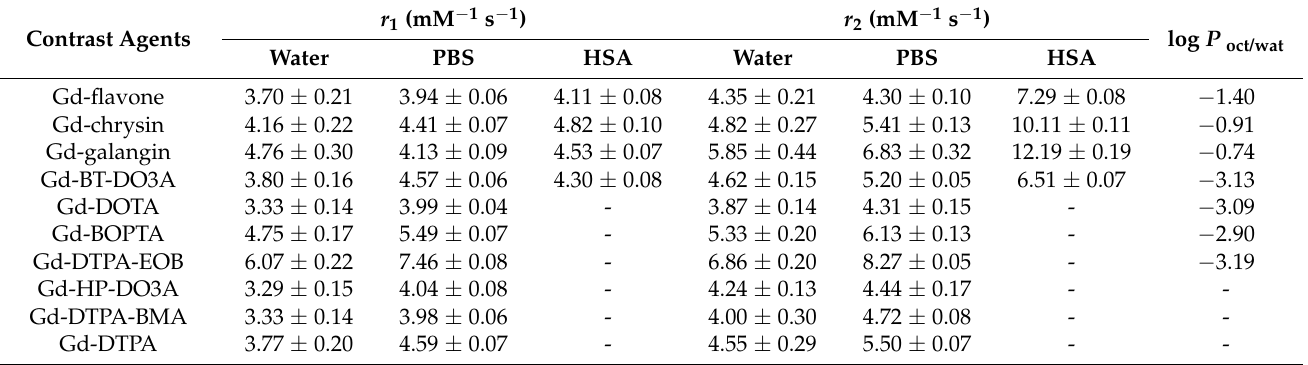
Table 1. Relaxivity and octanol-water partition coefficients of Gd-flavone, Gd-chrysin, Gd-galangin, Gd-BT-DO3A (Gadovist ® ), Gd-HP-DO3A (ProHance ® ), Gd-DTPA-BMA (Omniscan ® ), Gd-DOTA (Dotarem ® ), Gd-DTPA (Magnevist ® ), Gd-BOPTA (Multihance ® ) and Gd-DTPA-EOB (Primovist ® )